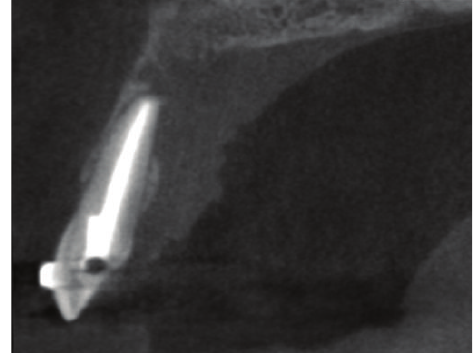
Figure 25: 1-year followup CBCT image in sagittal plane.